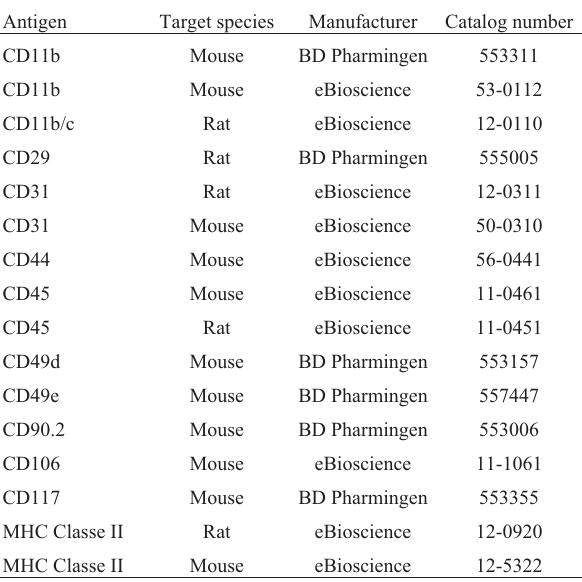
Table 1 - Antibodies used for immunophenotyping C. minutus MSC cul- tures. Antigen